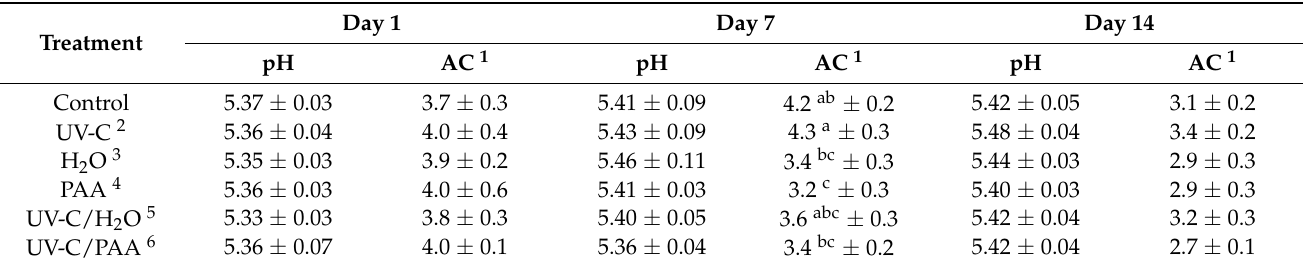
Table 8. LSM ± SE of the pH values and antioxidant capacity (AC) values of pork after UV-C, peracetic acid (PAA), and H 2 O treatments alone and in combination after 1, 7, and 14 days of storage ( n = 3).